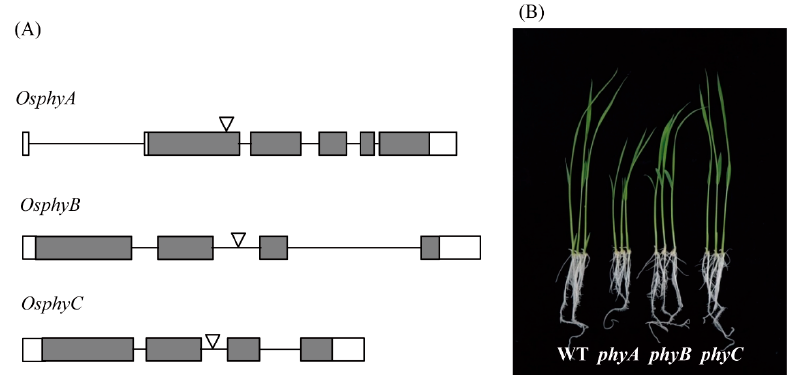
Figure 3. T-DNA insertional lines of rice Phy genes and their seedling phenotypes. ( A ) Simple schematic diagrams of rice Phy gene structures and T-DNA insertion sites [37]. ( B ) Phenotypes of 7-day-old rice seedlings grown in half-strength MS medium under a 12 h light/12 h dark cycle at 28 °C. Exons (filled boxes), introns (lines), and 5 ′ - and 3 ′ -untranslated regions (open boxes) are shown. Reverse triangles indicate T-DNA insertion sites.